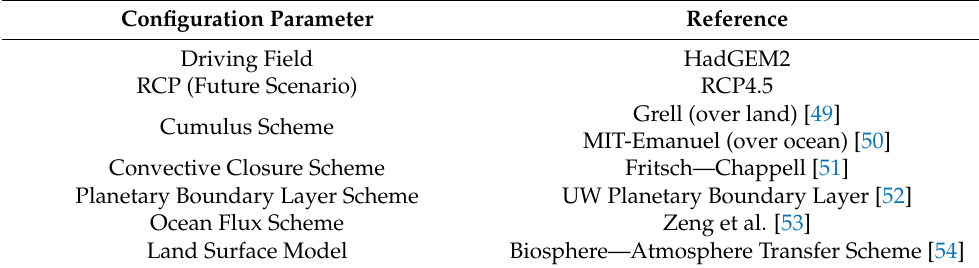
Table 1. Configuration parameters of the RegCM4